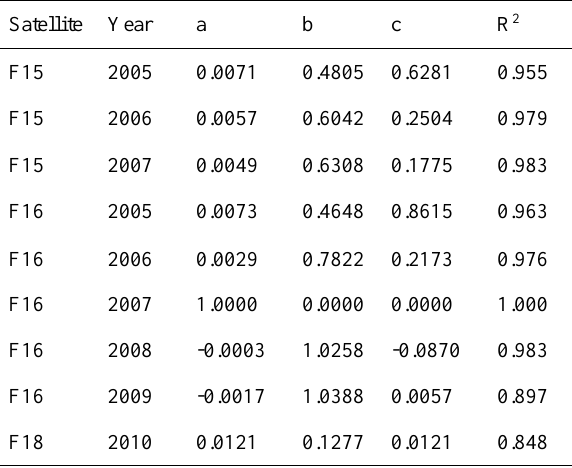
Table 1 . Inter-calibration coefficient used in the current study for the period between 2005 and 2010 (Yi et al., 2014) After inter-calibration, illuminated urban area (IUA) dome is calculated as (Eq. 2):